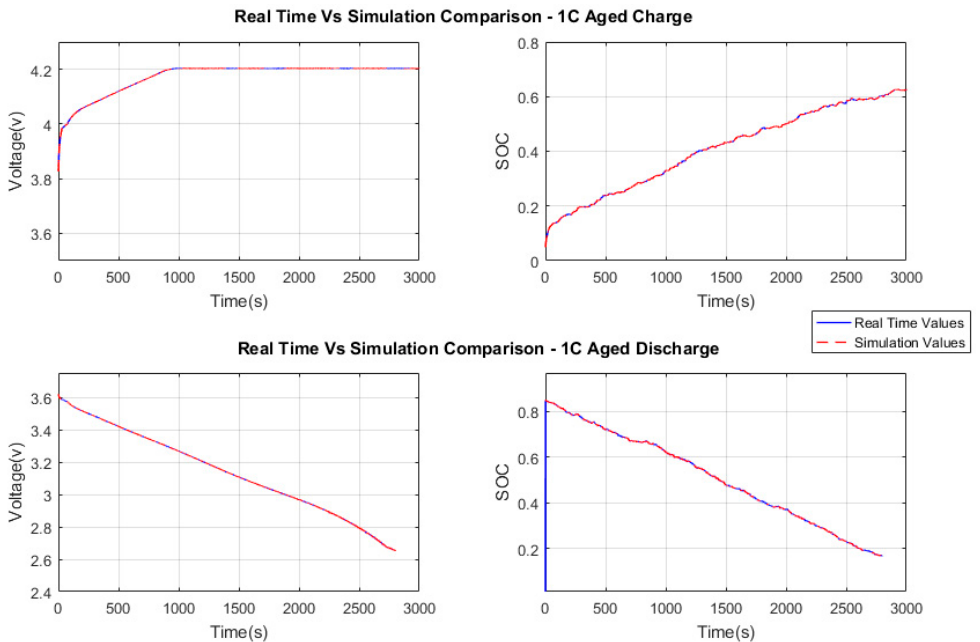
Figure 8. Simulated and real-time voltages and SOCs for the aged battery .